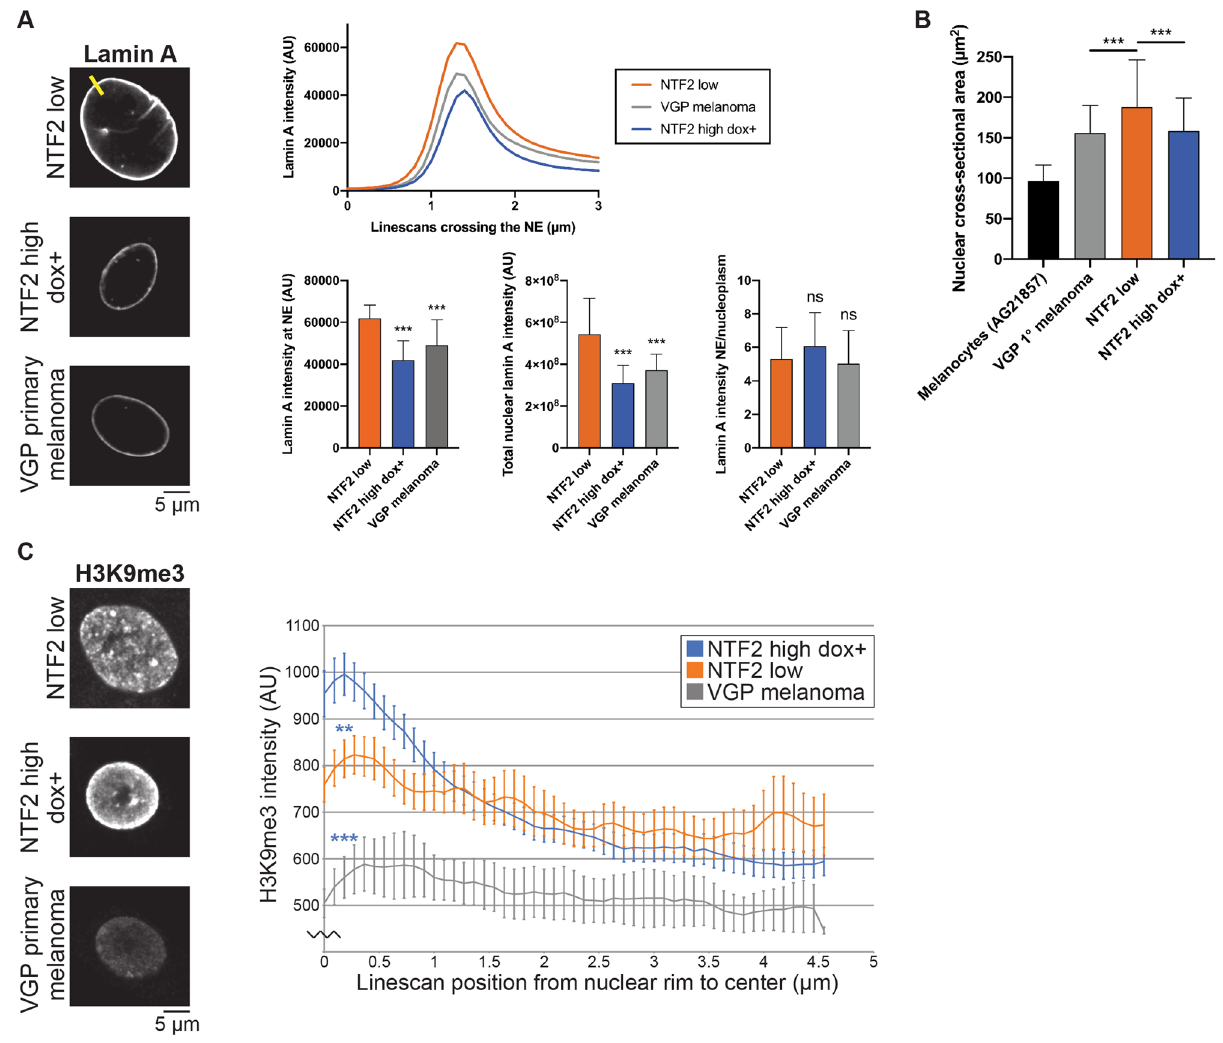
Figure 5. NTF2 affects lamin A nuclear localization, nuclear size, and heterochromatin distribution. VGP primary melanoma refers to a primary vertical growth phase melanoma cell line (WM983A) that was derived from the same patient as NTF2 low (WM983B) and represents an earlier stage of disease. (A) The indicated cells were stained for lamin A and representative images are shown. Images were acquired with the same exposure time and brightness/contrast were identically adjusted. Line scans were acquired across the nuclear rim as indicated by the yellow line. In the top graph, lamin A intensity was quantified across at least 50 line scans per cell line for two independent experiments (see “Methods”). To measure the lamin A intensity at the nuclear envelope (NE), the highest lamin A intensities from each line scan were averaged. To measure the total nuclear lamin A intensity, the total fluorescence intensity of thresholded nuclei was quantified for at least 102 nuclei per condition. To measure the NE/nucleoplasm lamin A intensity, the maximum value along the line scan was divided by the minimum value within the nucleus. Error bars are SD. One-way ANOVA followed by Dunnett’s multiple comparisons test with ***p < 0.0001 and ns not significant. We also measured a 44% reduction in lamin B1 staining intensity at the NE in NTF2 high dox + cells compared to NTF2 low cells (data not shown). (B) Nuclear cross-sectional area, which serves as a good proxy for nuclear surface area and volume 12,21,73,76 , was measured for at least 274 Hoechst-stained nuclei per cell line (918 nuclei on average). The normal melanocyte cell line is AG21857. Error bars are SD. One-way ANOVA followed by Dunnett’s multiple comparisons test with ***p < 0.0001. (C) The indicated cells were stained for the heterochromatin marker H3K9me3 and representative images are shown. Images were acquired with the same exposure time and brightness/contrast were identically adjusted. To quantify heterochromatin distribution, H3K9me3 intensity was quantified along line scans drawn from the nuclear rim toward the center (see “Methods”). Averages from at least 150 line scans are shown for each cell line for two independent experiments. Error bars are SEM. One-way ANOVA followed by Dunnett’s multiple comparisons test with **p < 0.01, ***p < 0.0001. The statistical comparisons are for NTF2 low and VGP primary melanoma compared to NTF2 high dox + at line scan position 0.2